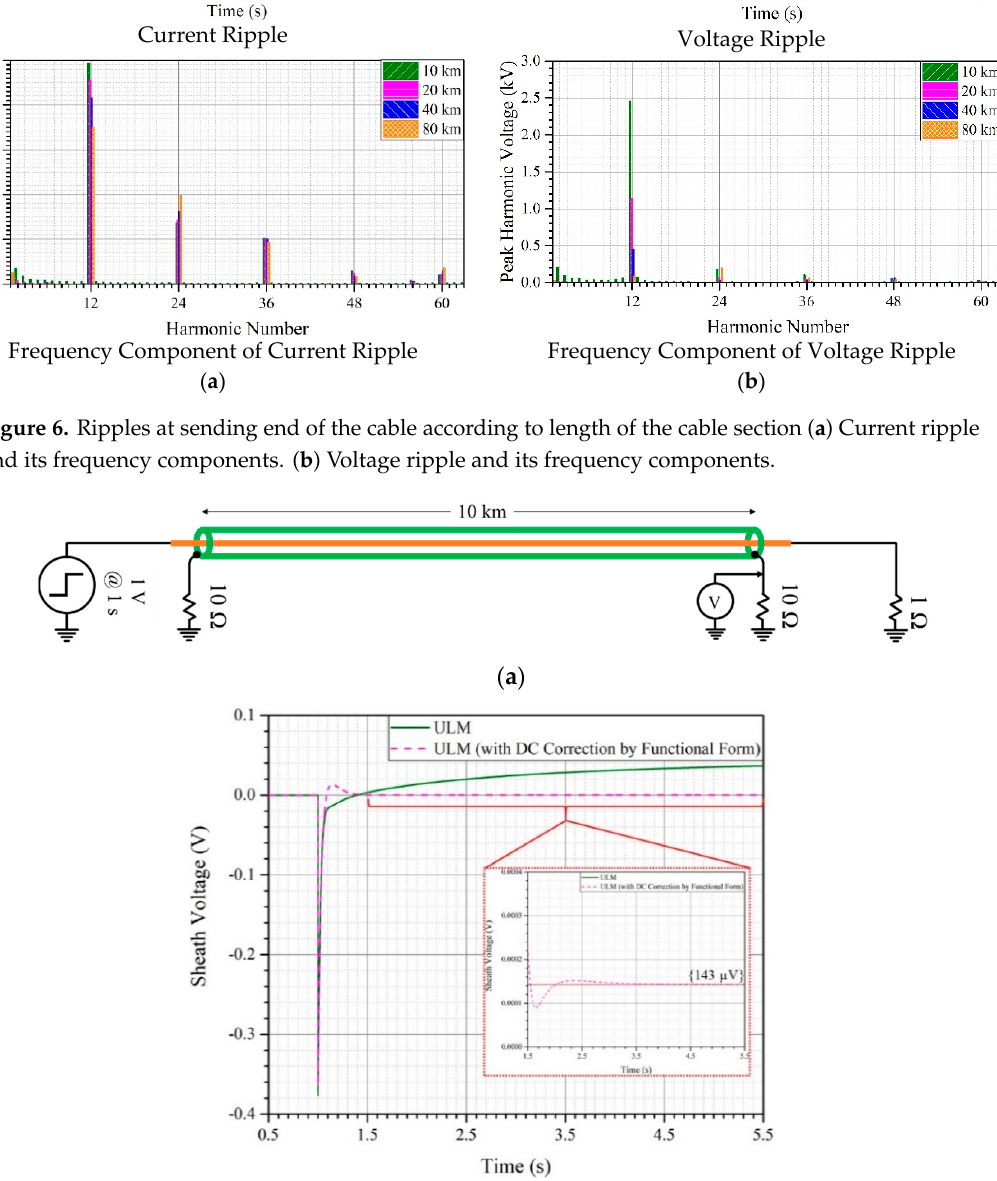
Figure 6. Ripples at sending end of the cable according to length of the cable section ( a ) Current ripple and its frequency components. ( b ) Voltage ripple and its frequency components.